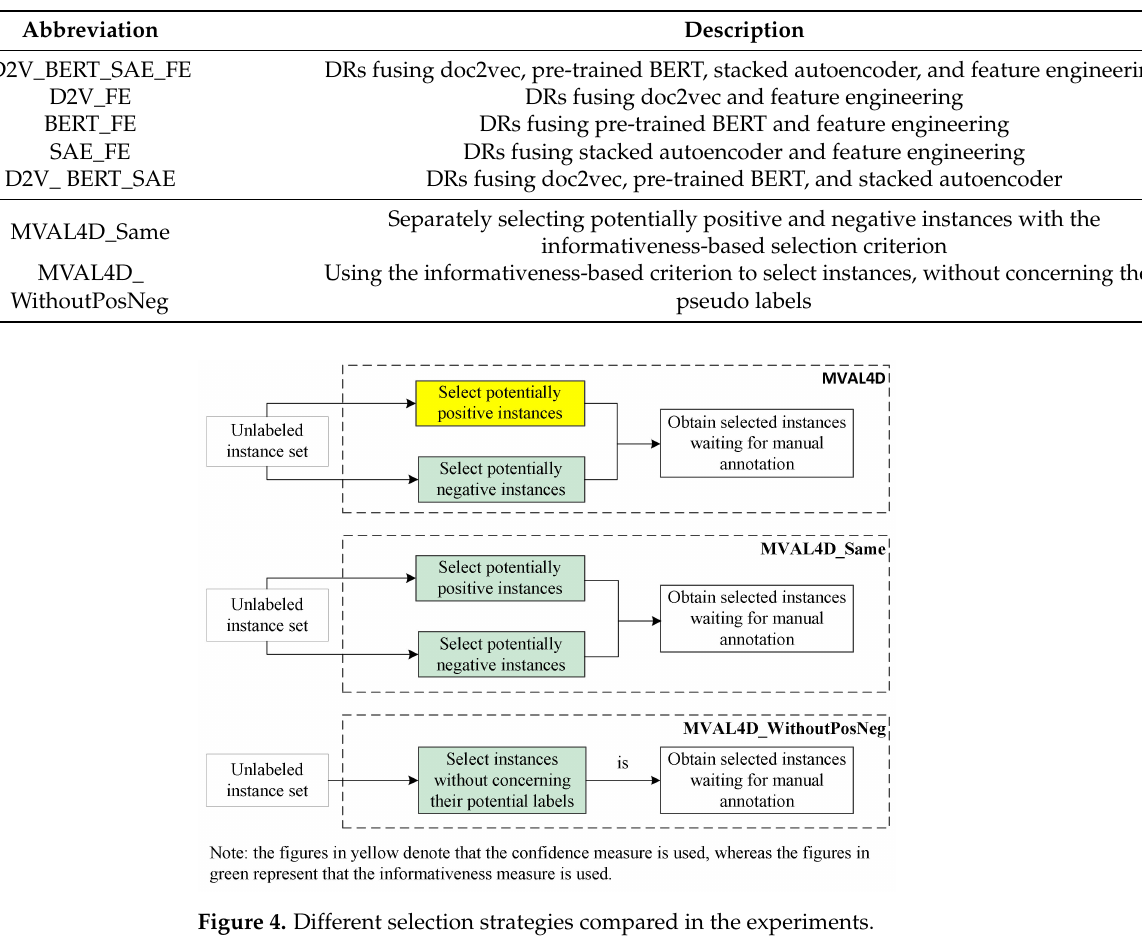
Table 3. Abbreviations and their descriptions in the experiments.